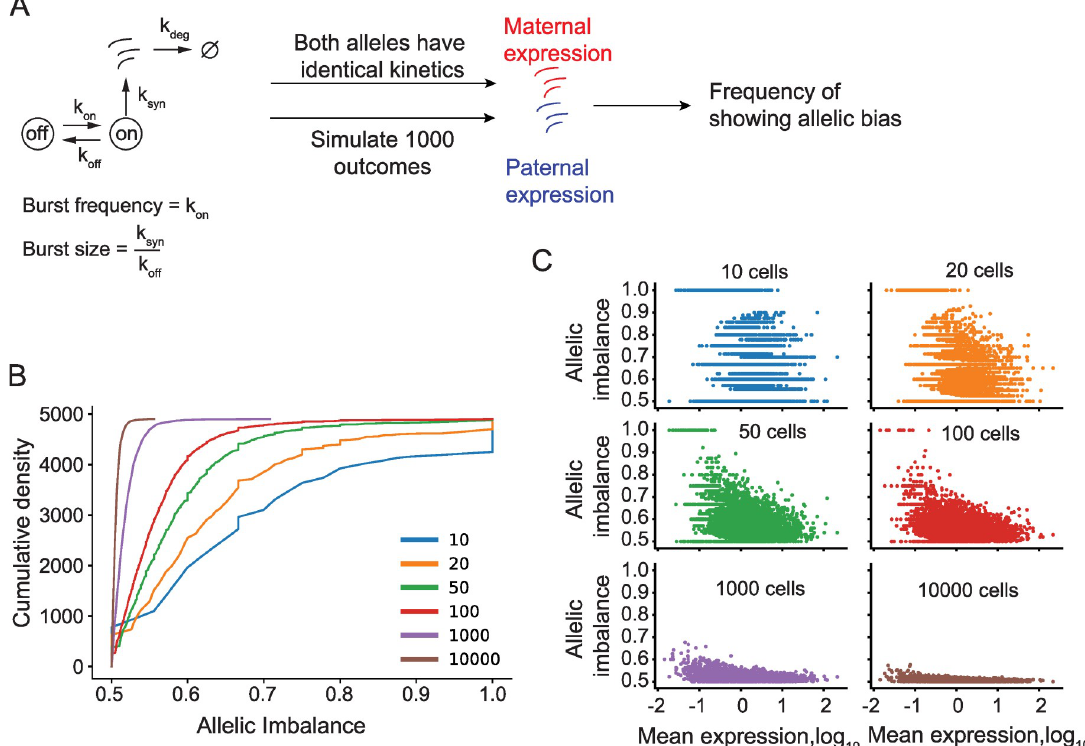
Fig 5. Low-expressed genes frequently show false positive allelic imbalance due to transcriptional bursting. (A) Outline of the simulation strategy. (B) The cumulative distribution of allelic bias of the simulated genes with the same kinetics ( n = 4,905 autosomal genes), where allele with the highest allelic bias is the chosen value for each gene. (C) The relationship between the mean expression of a gene and allelic bias based on the number of simulated cells ( n = 4,905 genes). Figure based on data from